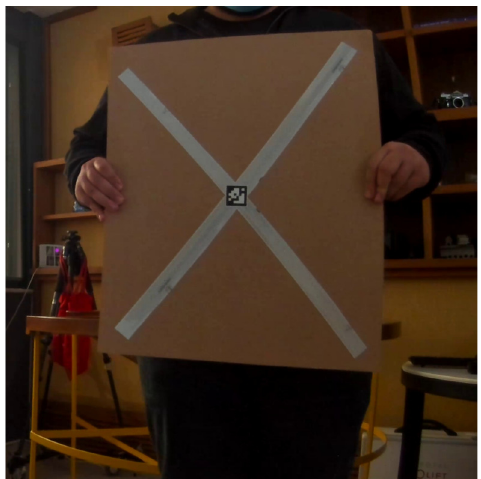
Figure 2. A close view of the proposed calibration object containing two crossing retroreflective stripes and the ApriTag fiducial mark in the middle.